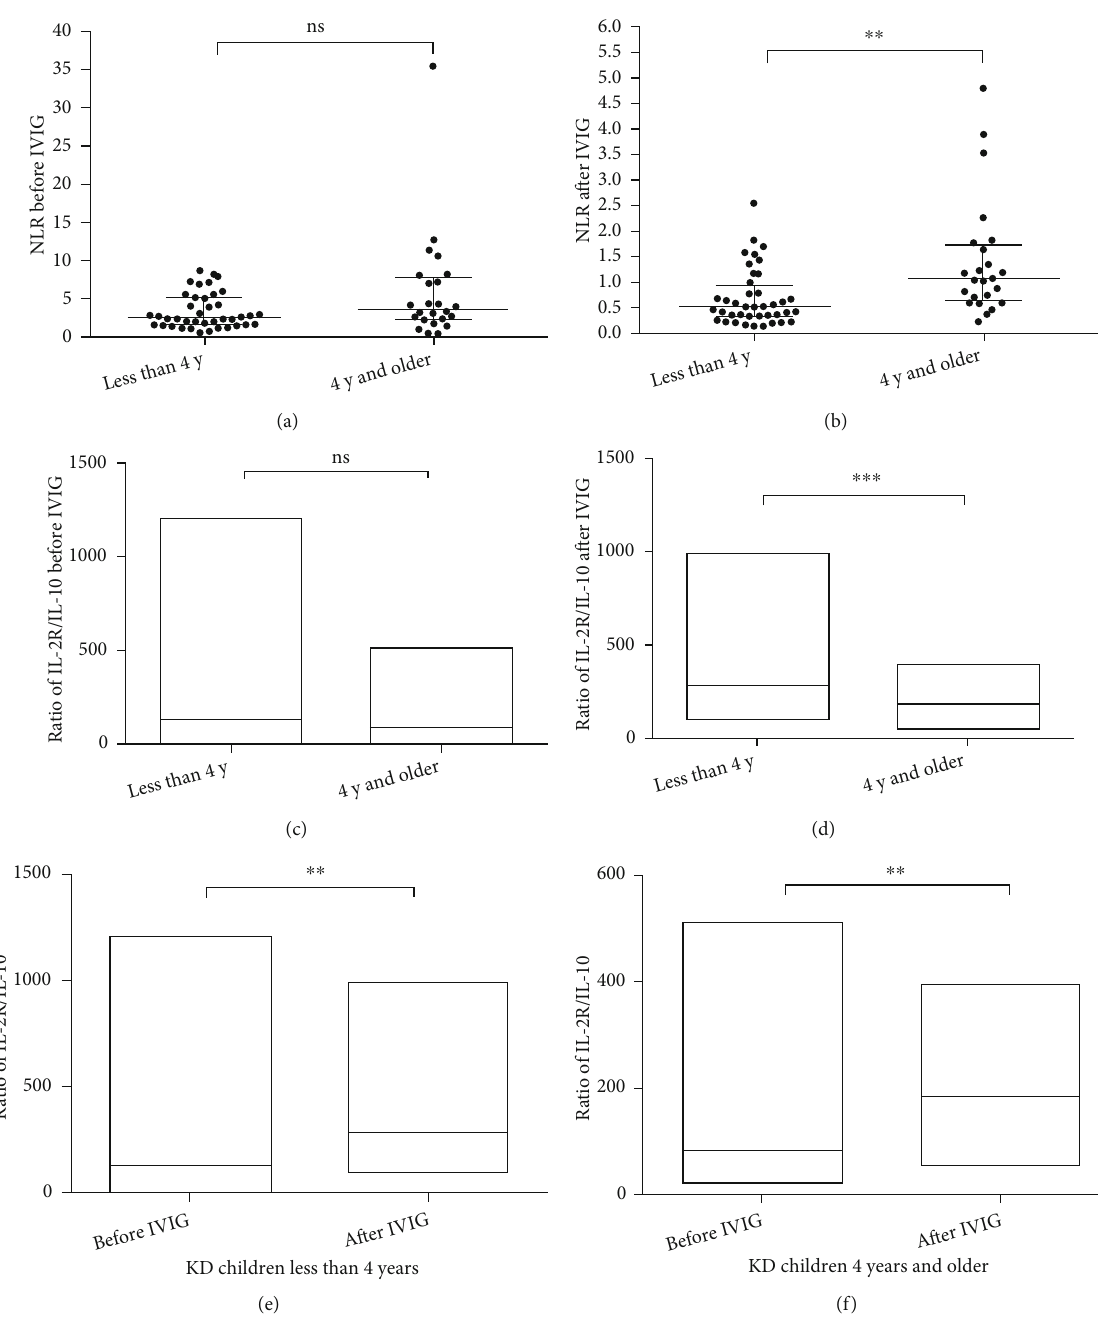
Figure 1: E ff ect of IVIG on the in fl ammatory response in children with KD under di ff erent conditions. (a) There was no signi fi cant di ff erence in the NLR before IVIG between the group of patients with KD who were < 4 years old and the group of patients who were ≥ 4 years old. (b) The NLR after IVIG in children with KD who were ≥ 4 years old was markedly higher than that in children with KD who were < 4 years old. ∗∗ P < 0 : 01 . (c) No signi fi cant di ff erence in the ratio of IL-2R/IL-10 before IVIG was observed between children with KD who were ≥ 4 years old and children with KD who were < 4 years old. (d) The ratio of IL-2R/IL-10 after IVIG was lower in children with KD who were ≥ 4 years old than in children with KD who were < 4 years old. ∗∗∗ P < 0 : 001 . (e) In children with KD who were < 4 years old, the ratio of IL-2R/IL-10 increased signi fi cantly after IVIG ( 317 ± 26 : 58 ) and was higher than that before IVIG ( 185 : 5 ± 32 : 45 ). ∗∗ P < 0 : 01 . (f) In children with KD who were ≥ 4 years old, the ratio of IL-2R/IL-10 increased after IVIG ( 193 ± 17 : 26 ) and was higher than that before IVIG ( 124 : 5 ± 22 : 6 ). ∗∗ P < 0 : 01 . CD: cluster of di ff erentiation; IL: interleukin; IVIG: intravenous immunoglobulin; KD: Kawasaki disease; NLR: neutrophil and lymphocyte ratio; ns: not signi fi cant; y: